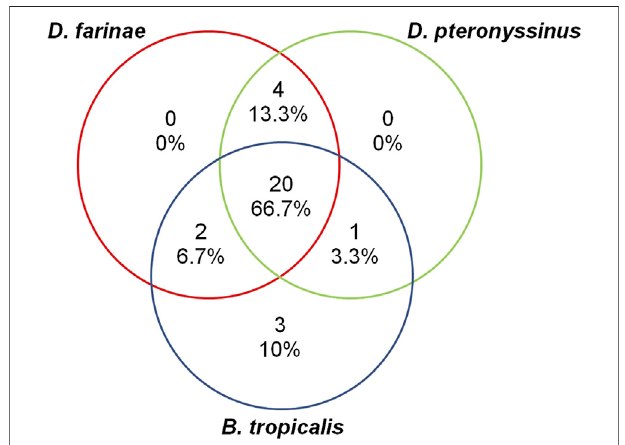
FIGURE 1 | The proportion of AR patients (total n = 30) sensitized to HDM allergens D. farinae , D. pteronyssinus , and B. tropicalis